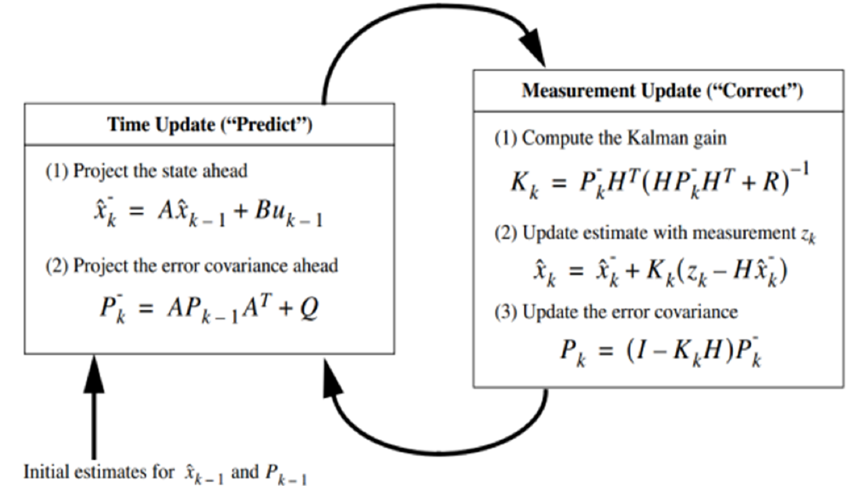
Figure 2. Flow Chart for the implementation of the KF, where x is the estimate of the state, A is the state transition matrix, B is the control matrix, u is the control variable, P is the state variance matrix, Q is the process variance matrix, K is the Kalman gain, H is the measurement matrix, z is the measurement variable, the “super minus” indicates a prior estimate and the subscript k indicates the time